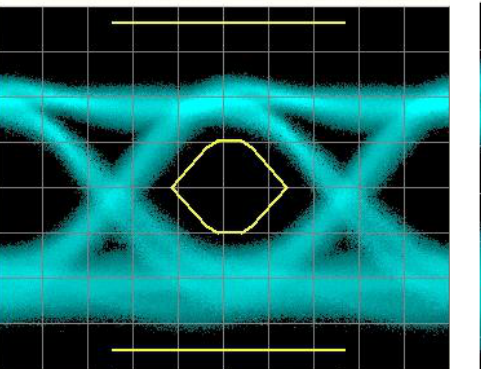
GigaPOF62-SR with EDC technology GigaPOF62 without EDC